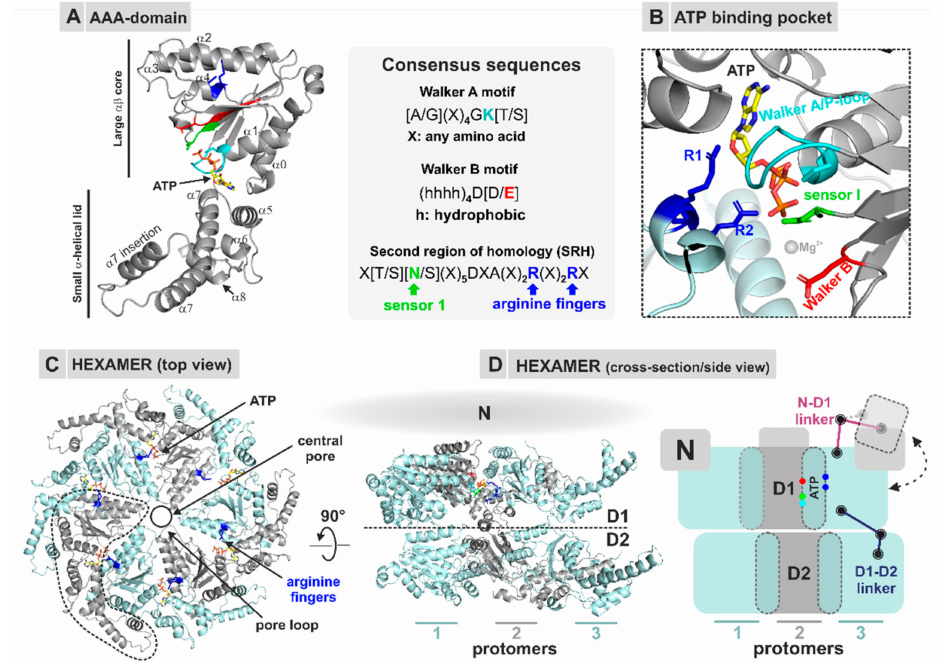
Figure 3. General architecture of type II AAA-ATPases. ( A ) D1 AAA module of the Chaetomium thermophilum typeIIAAA-ATPaseRix7(PDBID6MAT),composedofalarge αβ coreandasmall α -helical lid domain. Important structural elements (Walker A / B, R-finger, and sensor I) are colored as indicated. Each type II AAA-ATPase protomer contains two AAA modules (D1 and D2). ( B ) Magnification of the nucleotide binding pocket formed at the interface between two protomers. Nucleotide-sensing arginine fingers in the second region of homology (SRH) are provided by the neighboring protomers and allow communication of the nucleotide binding state. ( C ) D1 ring of Rix7 in top view. The monomers are colored alternately in gray and cyan. The ring-shaped hexameric assembly allows the formation of a central channel lined by conserved pore loops involved in substrate threading. The D2 ring is not depicted. ( D ) Cross-section of the Rix7 hexamer in side view (cartoon and schematic), showing the D1 and D2 ring. The flexible N-terminal domain (NTD) depicted in the scheme is not resolved in the shown cryo-EM structure of Rix7. The individual domains are connected by flexible linker sequences (only shown for protomer 3) that allow movements of the domains dependent on the ATPase cycle (e.g., up / down movement of the N-terminal domain) as well as communication between the